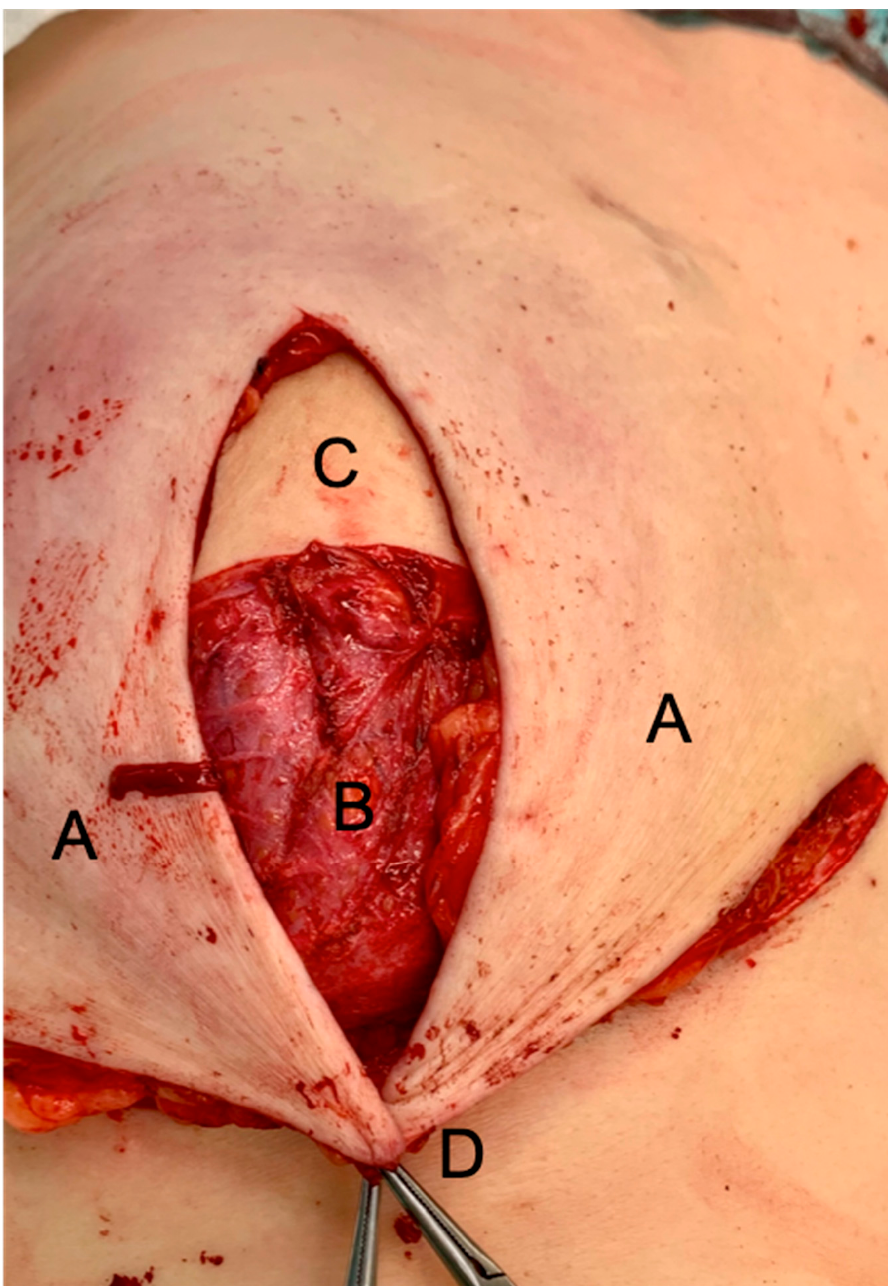
Figure 3. Intraoperative photograph of a DIEP flap inset after an SSM: ( A ), mastectomy skin flaps; ( B ), deepithelialized IBDF; ( C ), DIEP flap—the skin island to monitor flap perfusion can be excised later or it may serve for nipple reconstruction; ( D ), T-junction.